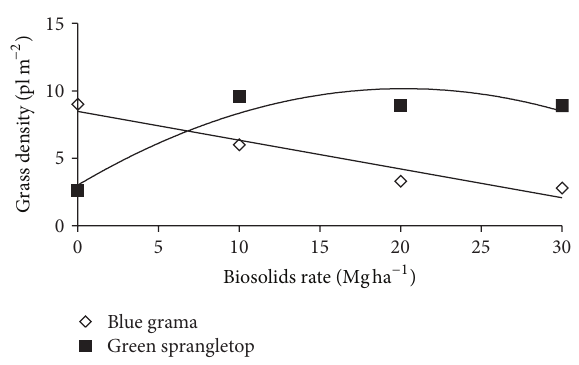
Figure 2: Grass density of blue grama ( Bouteloua gracilis ) and green sprangletop ( Leptochloa dubia ) under different biosolids rates duringfouryearsataseededabandonedfieldinChihuahua,Mexico. = 3.02 + 0.707𝑥 − 0.017𝑥 2 , 𝑃 = 0.001 , 𝑟 2 = 0.89 , 𝑌 Green-sprangletop = 8.47 − 0.213𝑥 , 𝑃 = 0.0001 , 𝑟 2 = 0.92 , 𝑛 = 24 . 𝑛 = 24 ; 𝑌 Blue-grama